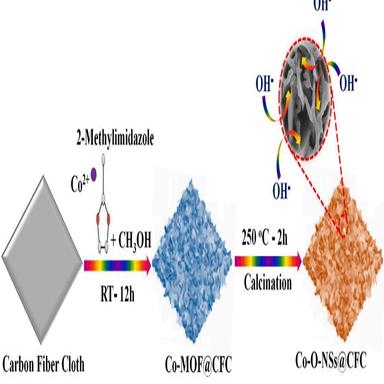
Schematic diagram, illustrated the formation mechanism for Co-O-NSs@CFC.